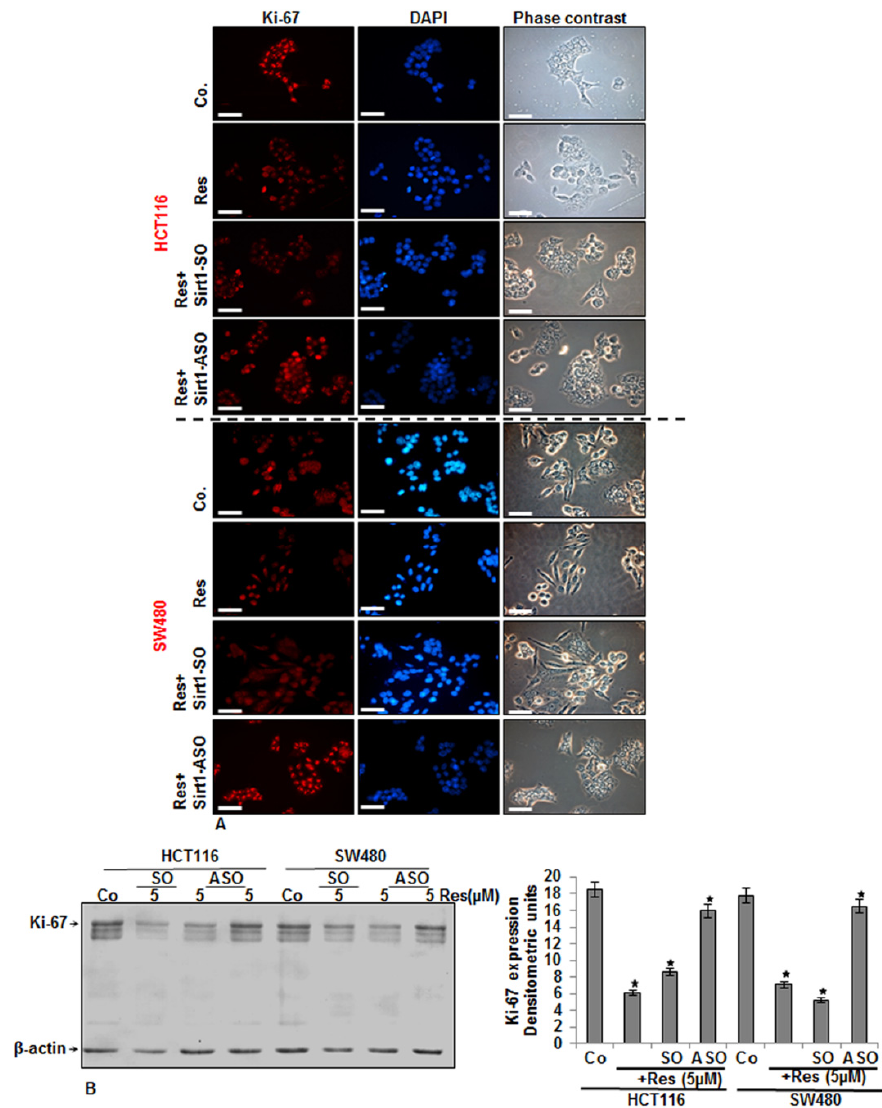
Figure 4. Effects of resveratrol and Sirt1 ‐ ASO on Ki ‐ 67 in CRC cells in monolayer culture as revealed by immunofluorescence microscopy. Serum ‐ starved HCT116 ( A ) and SW480 ( A ) cell lines in monolayer culture were either left untreated, or treated with resveratrol alone (5 μ M), or transfected with 0.5 μ M sense oligonucleotide (SO) control, or antisense oligonucleotides (ASO) against Sirt1 in the presence of Lipofectin transfection reagent (10 μ L/mL) for 24 h and co ‐ treated with resveratrol (5 μ M) for an additional 24 h and fixated with methanol. For immunolabeling, cells were incubated with primary antibodies against Ki ‐ 67 followed by incubation with rhodamine ‐ coupled secondary antibodies and counterstaining with DAPI to visualize cell nuclei. Images shown are representative of three different experiments. Magnification 400×; bar = 30 nm; ( B ) Effects of Sirt1 ‐ ASO on Ki ‐ 67 expression in CRC cells in monolayer culture. Serum ‐ starved HCT116 and SW480 cell lines in monolayer culture were either left untreated or transfected with 0.5 μ M sense oligonucleotide (SO) control or antisense oligonucleotides (ASO) against Sirt1 in the presence of Lipofectin transfection reagent (10 μ L/mL) and co ‐ treated with resveratrol (5 μ M) for 24 h. Whole cell lysates were prepared and analyzed by immunoblotting with antibodies against Ki ‐ 67. Housekeeping protein β‐ actin served as a loading control in all experiments. Densitometric evaluation of protein expression as revealed by Western blot analysis was performed in triplicate. Values were compared to the control and statistically ‐ significant values with p < 0.05. Significant values are marked with an asterisk (*).